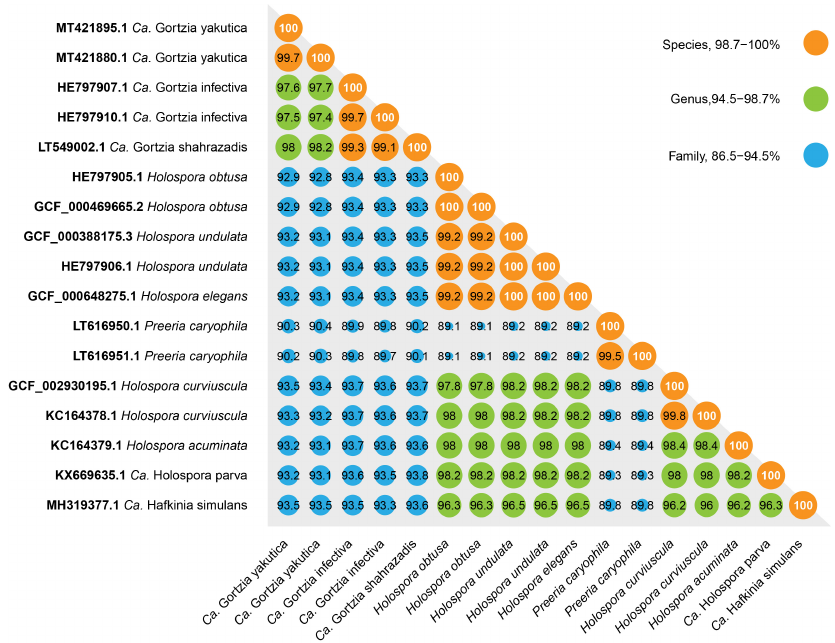
Figure 5. Divergence of Holospora -like bacteria based on 16S rRNA gene. Pairwise sequence similarity was calculated from the trimmed multiple sequence alignment used for phylogeny inference.